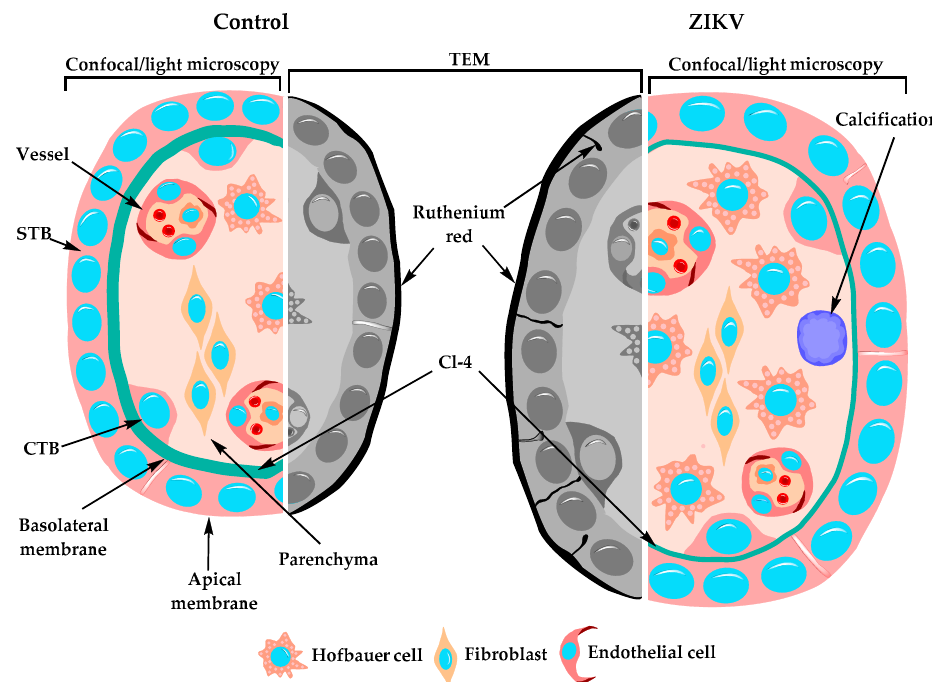
Figure 6. Schematic representation of the changes observed in chorionic villi of ZIKV-infected women. Chorionic villi derived from women infected with ZIKV during pregnancy, displayed several alterations including Hofbauer cell hyperplasia, increased diameter of microvilli, intravillous calcifications, and a STB layer with a diminished expression of claudin-4 and permeable to ruthenium red passage though the paracellular pathway.